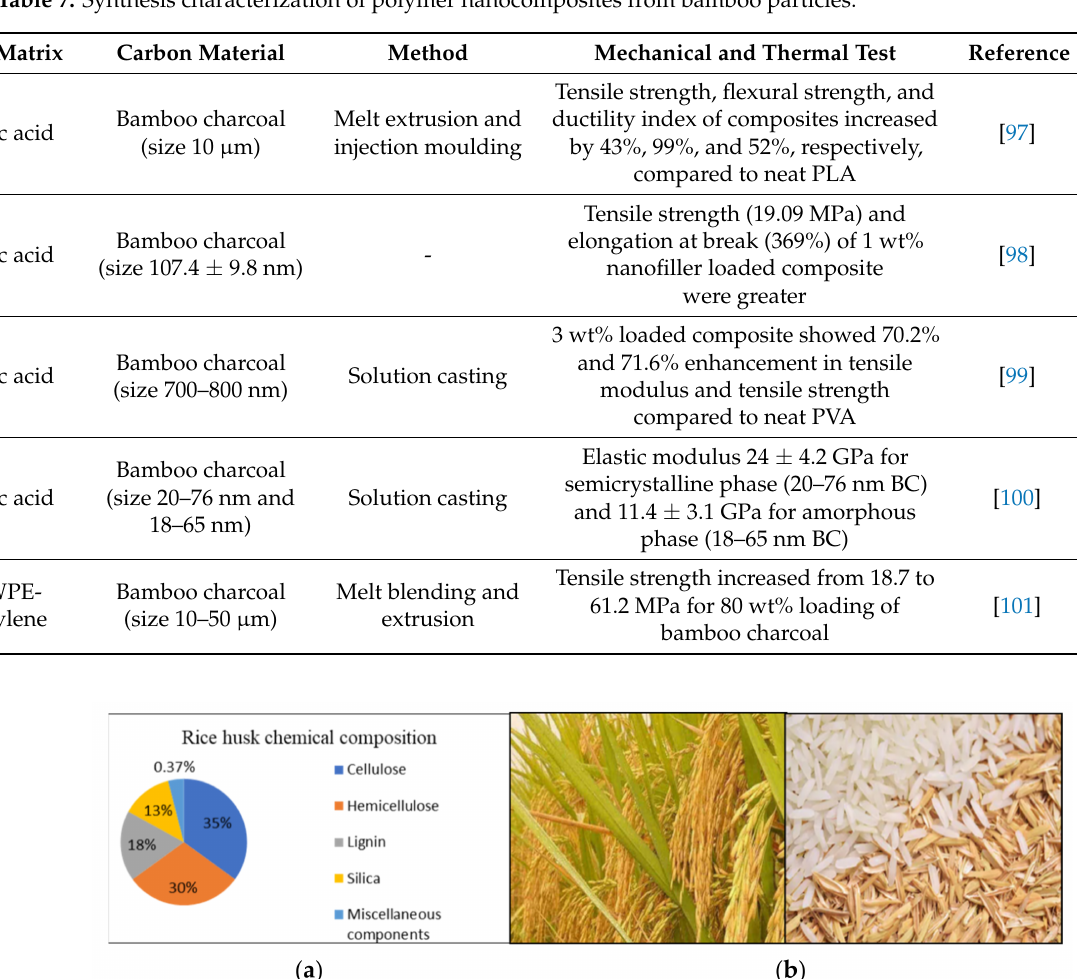
Table 7. Synthesis characterization of polymer nanocomposites from bamboo particles.